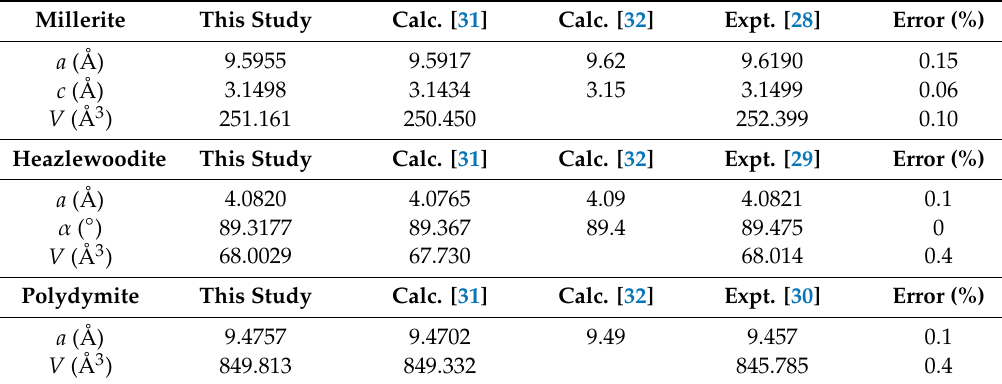
Table 1. Comparison of the calculated and measured crystal structures of millerite (NiS), heazlewoodite